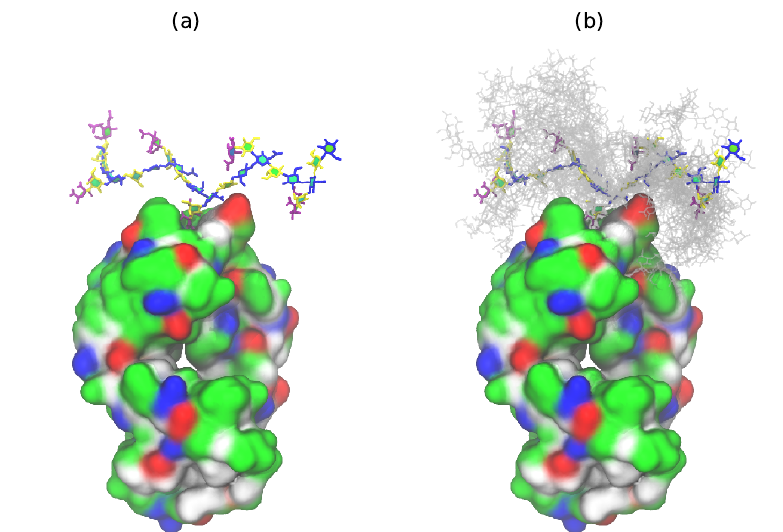
Figure 4. GBSIII 6RU structures superimposed on the bound branch point of the DP2-FAb crystal structure from Carboni et al. [13] (PDB ID code 5M63): ( a ) a single representative structure and ( b ) superimposed conformational snapshots at 12.5 ns intervals (with the first 125 ns discarded as